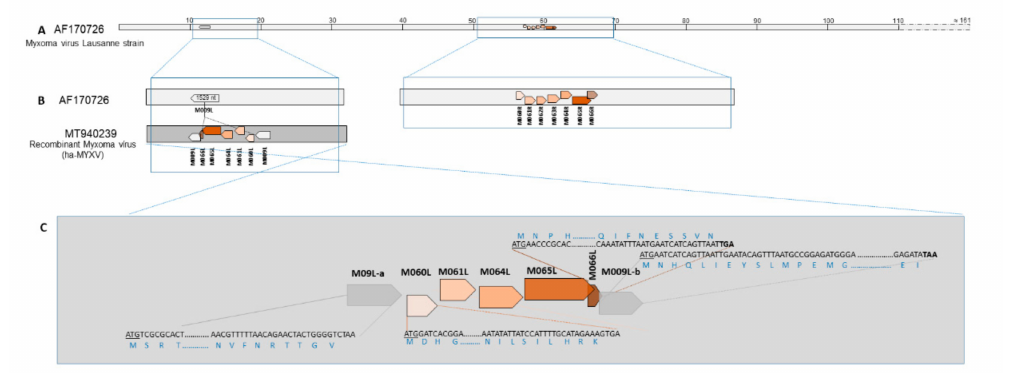
Figure 5. ( A ) Linear genomic organisation of the reference Lausanne strain with the location of ORFs M009L and ORFs M061R and M66R. ( B ) Schematic representation comparing the uninterrupted receptor ORF M009L in the Lausanne strain with the insert in ha-MYXV. ( C ) Detail on the flaking regions of